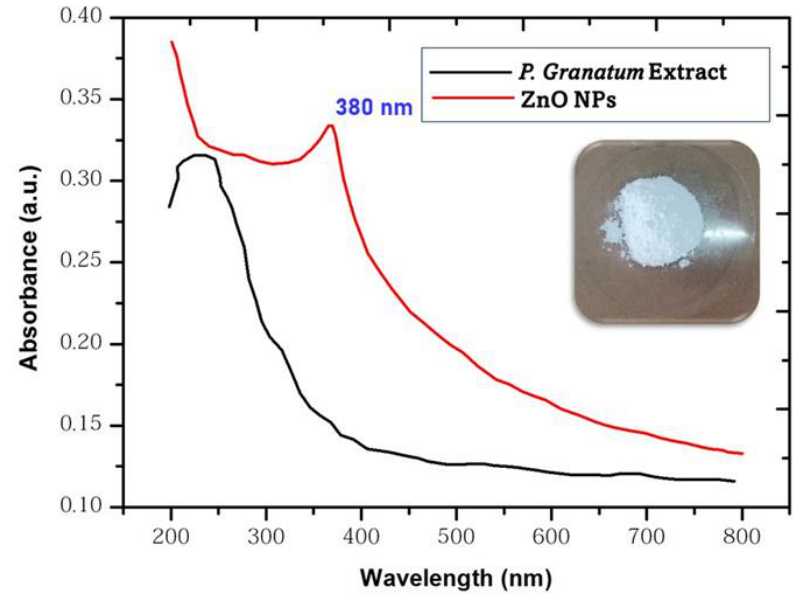
Crystals 2023 , 13 , 172 6 of 14 Figure 3. Histogram of ZnO particle size distribution. 3.3. UV-Visible Spectroscopic Analysis Surface plasmon resonance distinguishes the absorbance pattern of nanoparticles from that of their bulk counterparts. The UV-visible measurement was used to confirm the formation of nanoparticles. Figure 4 depicts the UV-visible absorption spectrum of the ZnO-NPs. Using a systonic UV spectrophotometer, the substance was analyzed between